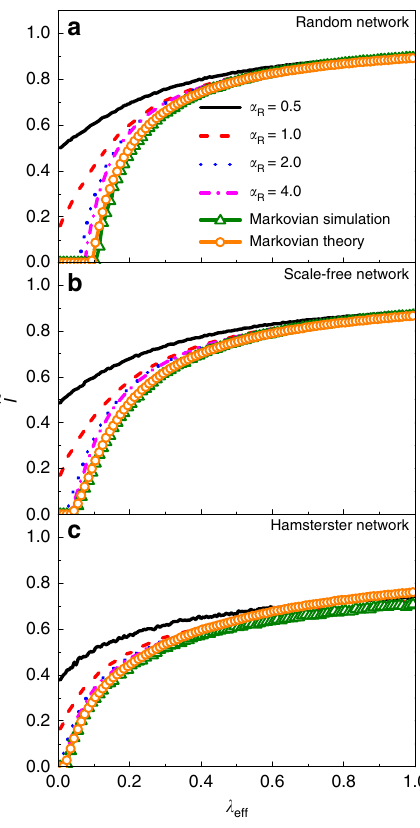
Fig. 5 Demonstration of approximate equivalence. Shown are the stationary infected density with type-I activation mechanism for a random, b scale- free, and c Hamsterster networks, which are the same as the networks in Fig. 3, for β R = 0.5. Solid, dashed, dotted, and dot-dashed curves represent the results for α R = 0.5, 1, 2, 4, respectively. Triangles and circles denote the results from the Markovian process and its analytical solution, respectively. An approximate equivalence arises in the regime of large infected